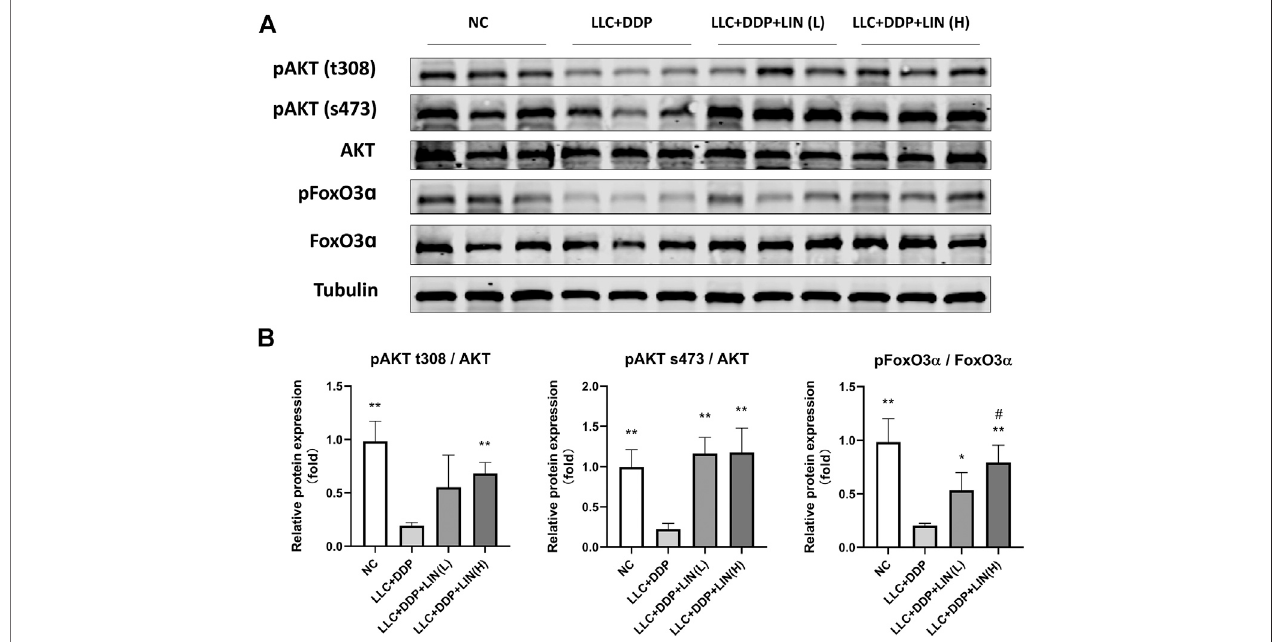
FIGURE4| LINactivatedAkt/FoxOpathwayinGAmuscle (A) ProteinexpressionofMyHC,MuRF1,Atrogin1wasevaluatedbywesternblotting,Tubulinwasused asaninternalcontrol. (B) Therelativeexpressionlevelsoftheproteinswerequanti fi edusingImageJsoftwareandnormalizedtoTubulinandcorrectedtoGroupNC.Data shown as mean ± S.E.M. (n (cid:2) 3); * p < 0.05, ** p < 0.01 vs. Group LLC + DDP, # p < 0.05 vs. Group LLC + DDP +